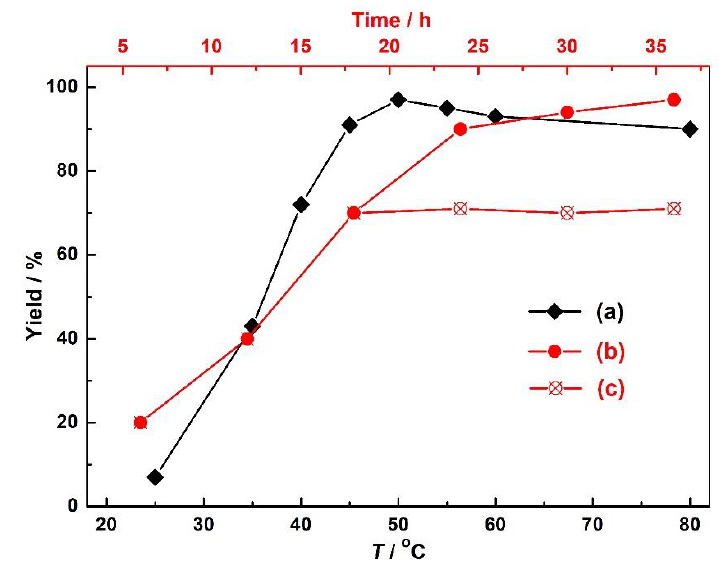
Figure 6. ( a ) The influences of the reaction temperature on the carboxylic cyclization of propargylic alcohols with CO 2 ; ( b ) catalytic traces of the catalysis performed under optimal conditions and with the catalyst 1 filtered after 18 h ( c ).